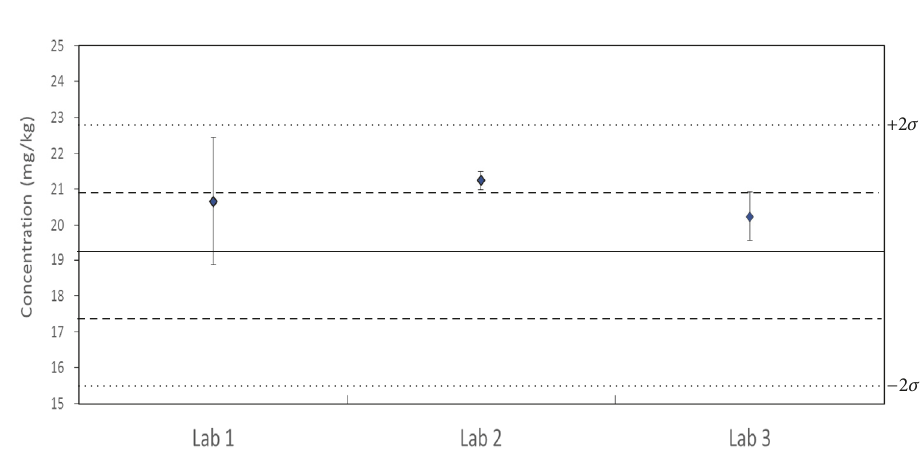
Figure 3: Interval of variation for CRM between three participating laboratories acceptance limits as 𝑋 𝑟𝑒𝑓 ± 2𝜎 (15.3 ∼ 22.9 mg/Kg).